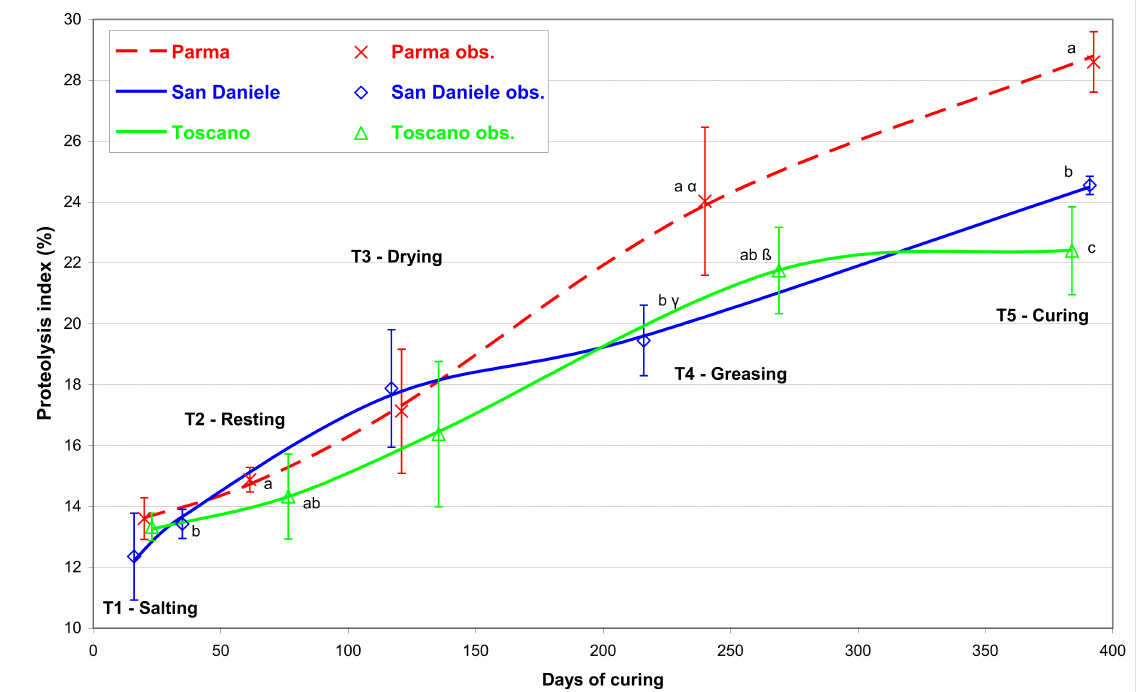
Figure 3. Evolution of the proteolysis index in the biceps femoris muscle during the processing of the main Italian prosciutto PDOs (obs. = observed mean with standard deviation values; a, b, c: differences between PDOs within a ripening phase p ≤ 0.05; α , β , γ : differences between PDOs within the ripening phase p ≤